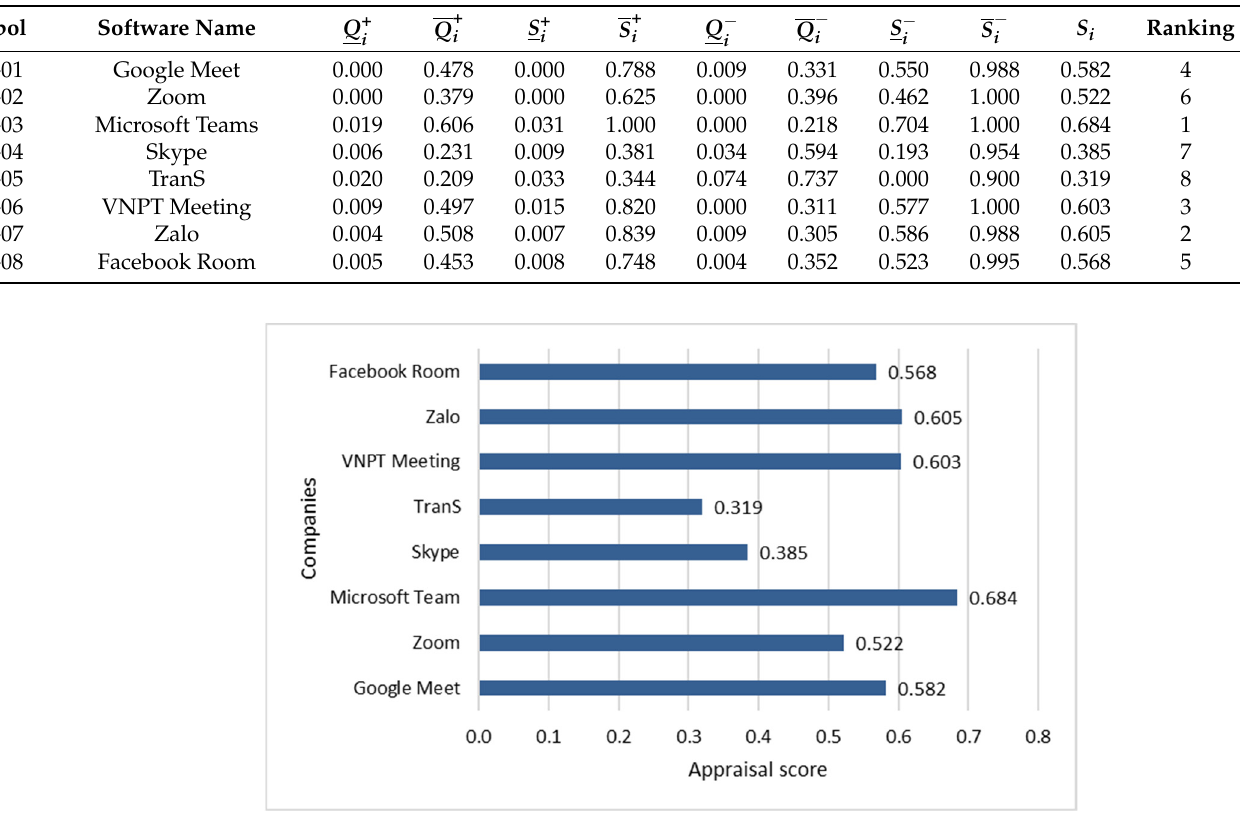
Table 10. The fluctuation coefficient value of G-EDAS.